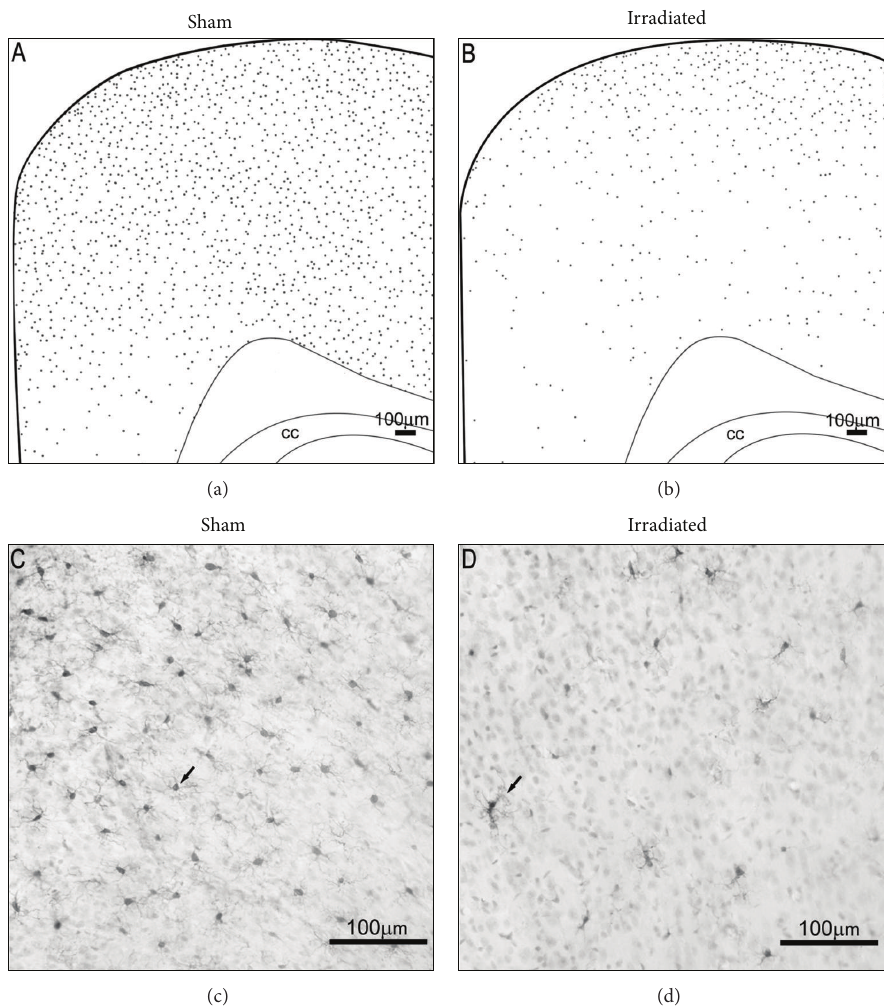
Figure 6: Effect of a single 4Gy dose of X-ray radiation on microglia in the developing rat brain 24hr after exposure. (a, b) A schematic representation of microglia distribution (gray dots) in the cerebral cortex showing that RT-induced loss of microglia is more pronounced in inner layers relative to superficial layers. (c, d) Representative 20x images of Iba1+ staining in the retrosplenial cortex showing that RT not only reduces the number of microglia but also alters their